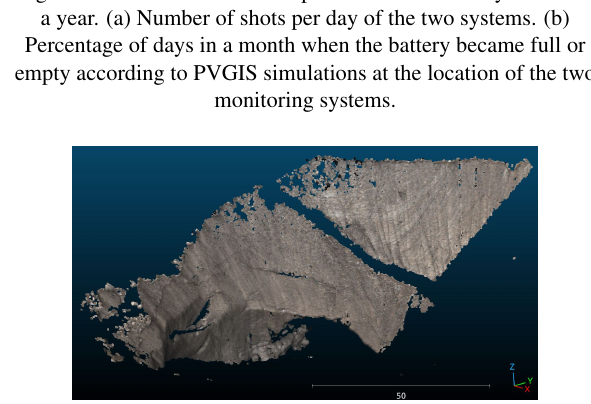
Figure 10. Dense point cloud built from the stereo-pair of 28/07/22. The point cloud was composed of ∼ 6 × 10 6 points, with an average point density of ∼ 1000pts m − 2 .